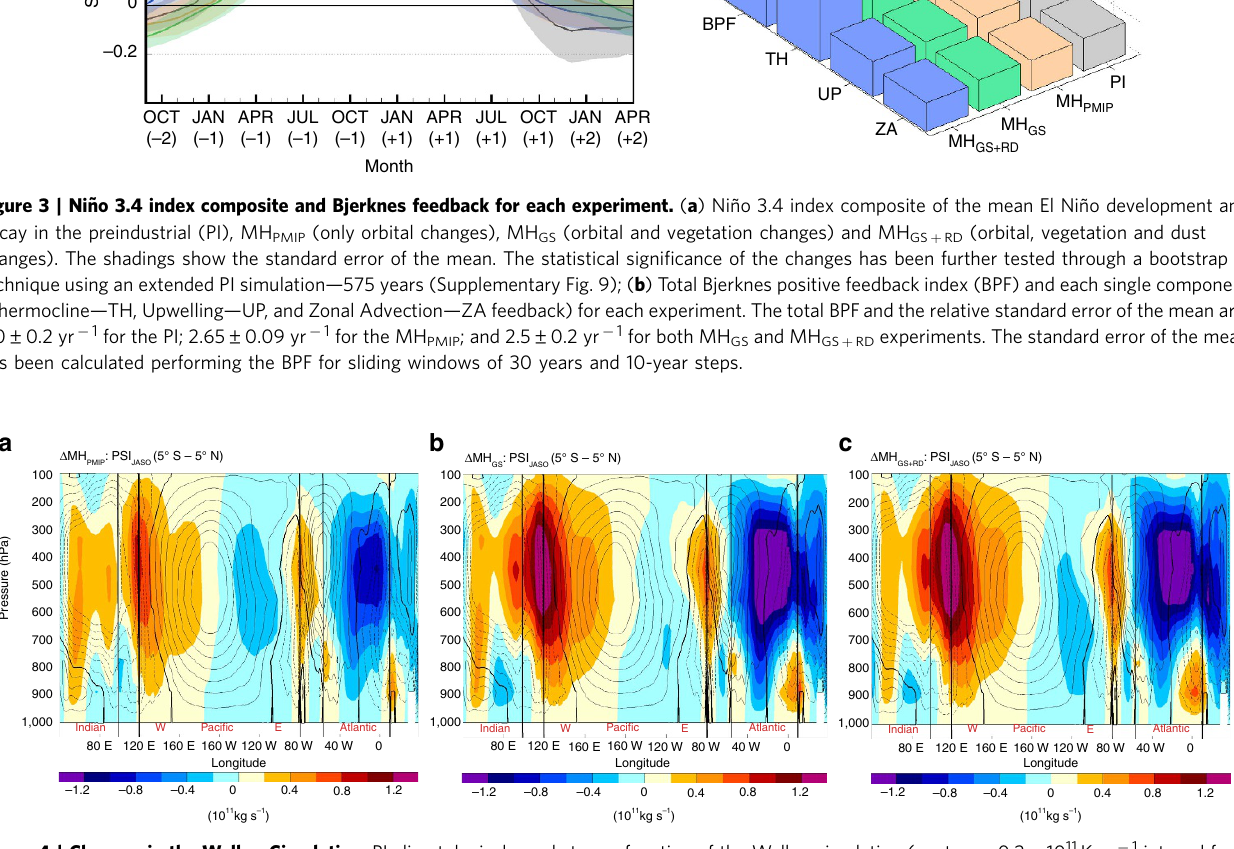
Figure 4 | Changes in the Walker Circulation. PI climatological zonal stream function of the Walker circulation (contours: 0.2 (cid:3) 10 11 Kgs (cid:2) 1 interval from (cid:2) 1.4 to 1.4 (cid:3) 10 11 kgs (cid:2) 1 ; 0 line in bold) and associated changes (shadings) in each MH experiment ( a – c ) relative to the